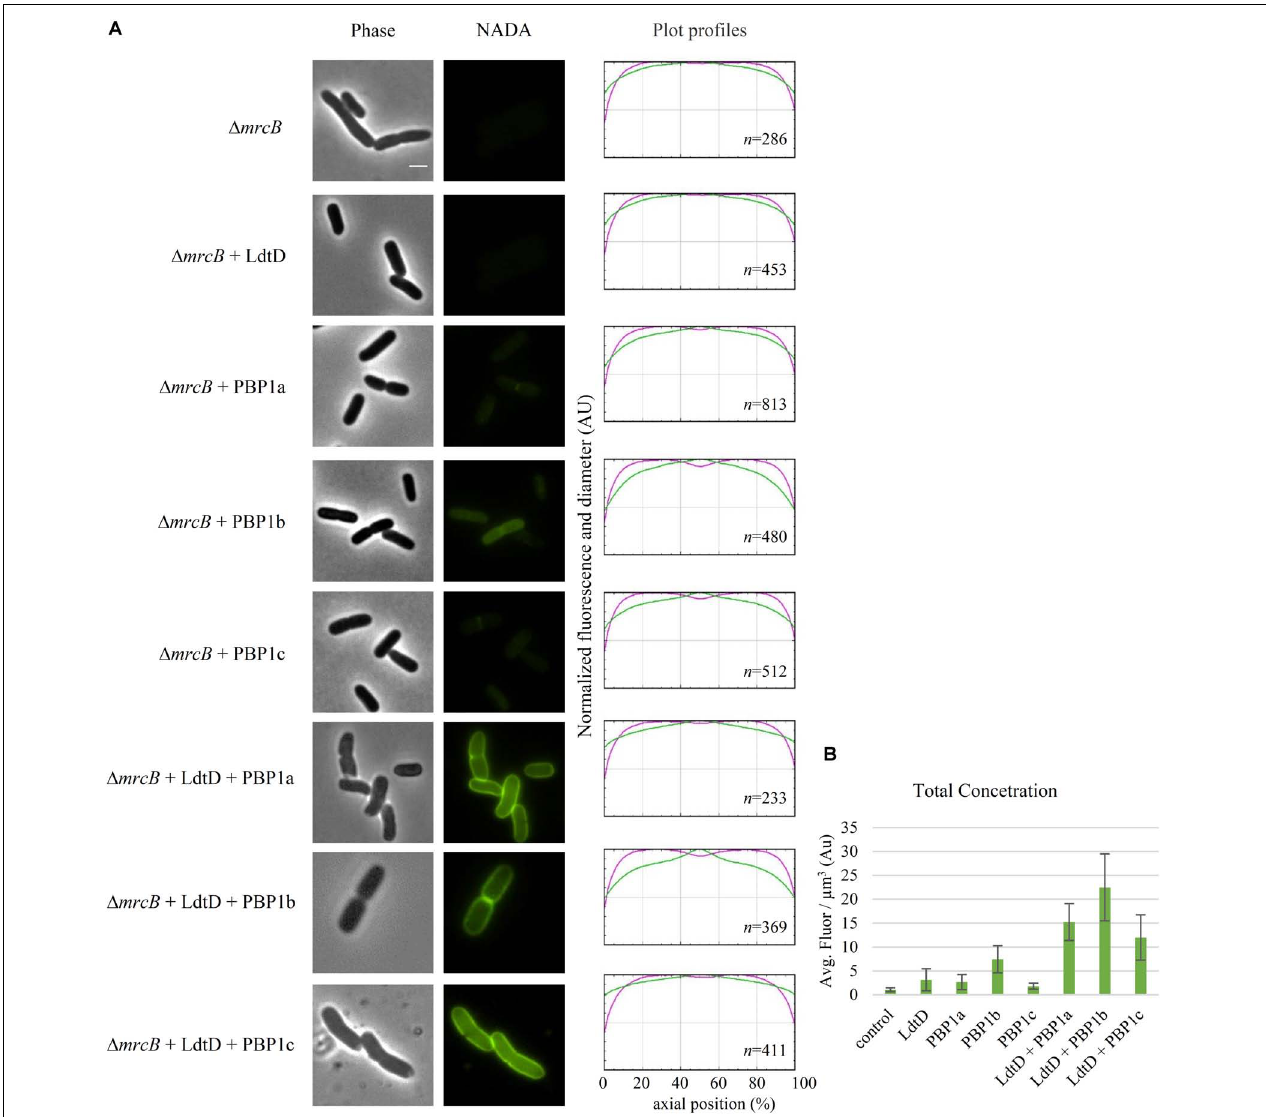
FIGURE 5 | Effect of plasmid-expressed genes encoding class A PBPs on NADA incorporation by LdtD. (A) Phase contrast and corresponding fluorescence images of BW25113 (cid:49) mrcB (without PBP1b) (control) expressing or not ldtD , mrcA , mrcB , pbpC , ldtD and mrcA , ldtD and mrcB , or ldtD and pbpC , labeled with a 0.5 mM NADA pulse of 2 min. Scale bar, 2 µ m. The right panel shows the average normalized fluorescence profiles (green) and diameter (purple) per cell (from 0.0 to 1.0) plotted against normalized cell length (from 0 to 100%). n represents the number of cells analyzed. (B) Concentration is the NADA fluorescence (signal per µ m 3 average cell volume). Quantification of the incorporated NADA in cells of BW25113 (cid:49) mrcB (control) or expressing ldtD , mrcA , mrcB , pbpC , ldtD and mrcA , ldtD and mrcB , and ldtD and pbpC . The values are mean ± SD of n number of cells. n is indicated on the fluorescence profiles.